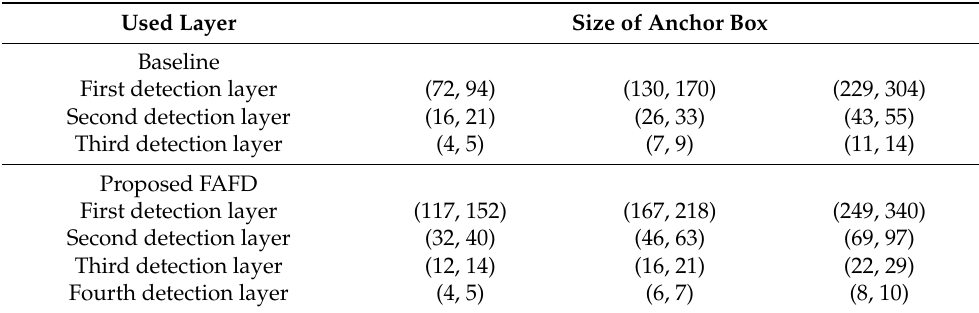
Table 1. Anchor boxes (In (w,h) ‘w’ and ‘h’ represent the width and the height of the anchor box, respectively). Used Layer Size of Anchor